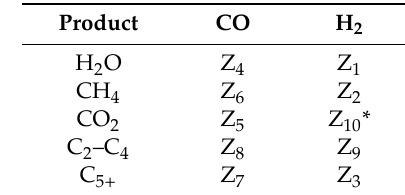
Table 1. Key for understanding the impact parameters and their corresponding equation (columns 2 and 3) and product (column 1).